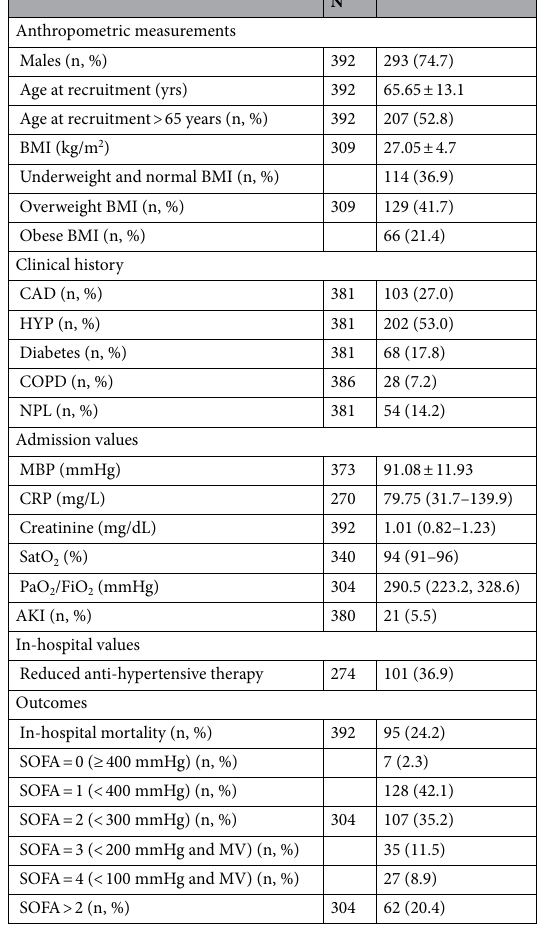
Table 1. Demographic and clinical characteristics of study patients with SARS-CoV-2 infection. Continuous variables were reported as mean ± SD whereas categorical variables as total frequencies and percentages. Skewed variables are presented as median (interquartile range). CAD coronary artery disease, HYP history of hypertension or use of at least one anti-hypertensive drug , COPD chronic obstructive pulmonary disease, NPL malignancy, CRP C-reactive protein, MBP mean arterial blood pressure, SatO 2 peripheral arterial oxygen saturation, AKI acute kidney failure, MV , mechanical ventilation. SOFA score was evaluated on PaO 2 /FiO 2 values (where PaO 2 partial pressure of arterial oxygen and FiO 2 fraction of inspired